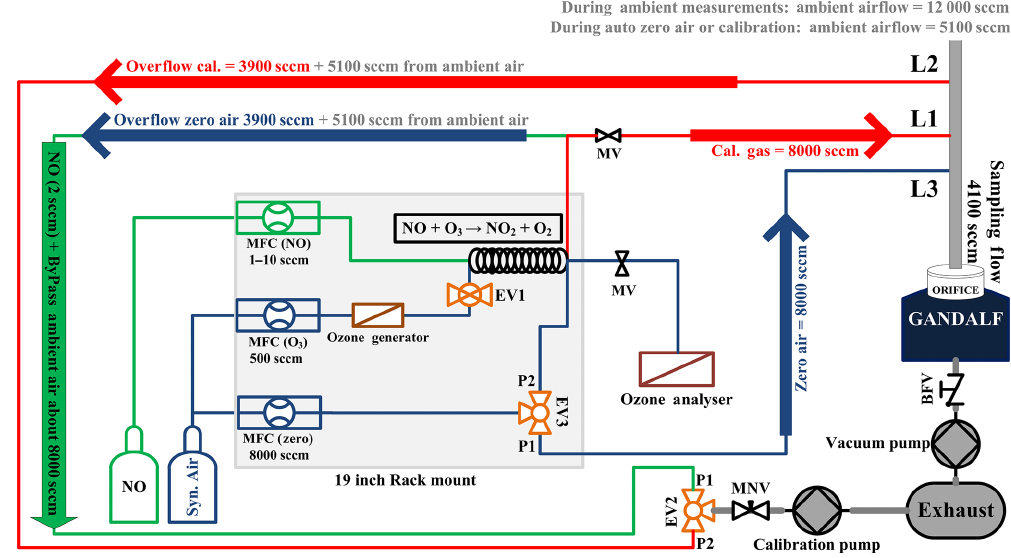
Figure 7. Schematic set-up for the automated calibrations during PARADE 2011.